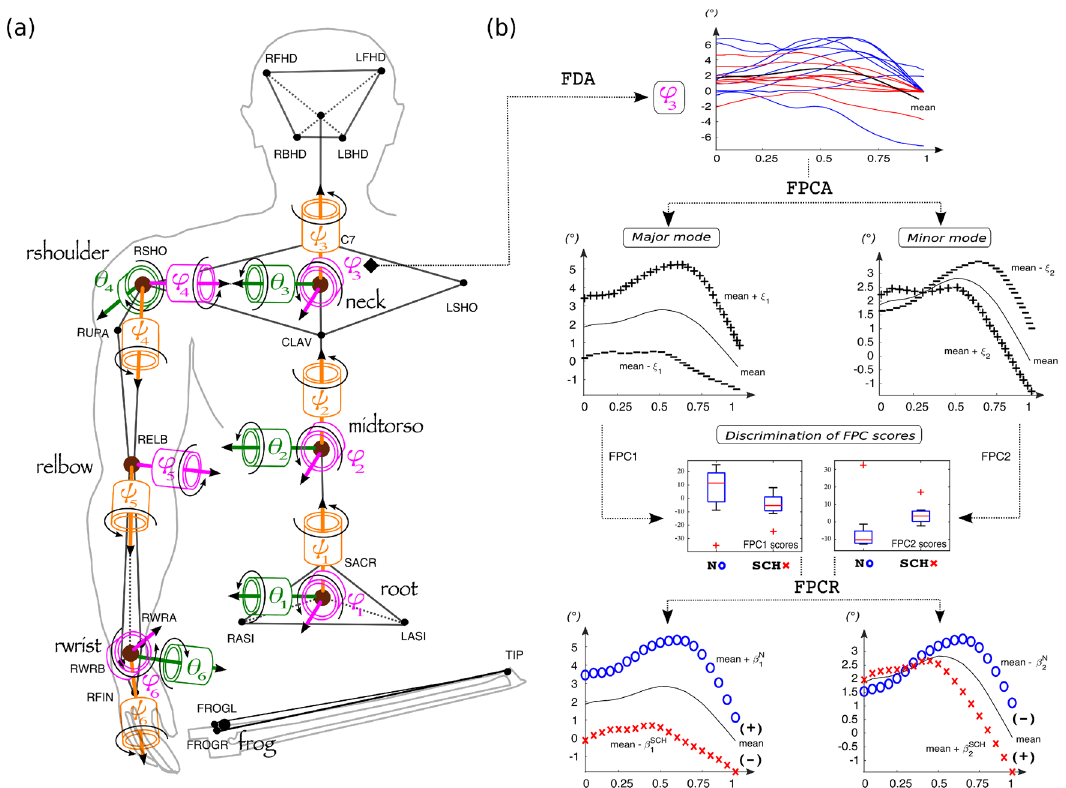
Figure 2. ( a ) Kinematic model of the cellists’ trunk and right arm bowing presented at rest (frontal view). This inertial system is composed of six key joints modeled as three single axes rotational joints in the Cardan/Euler angle representation {roll ( ψ n ), pitch ( θ n ), yaw ( φ n )} where n ∈ [ 1 . . . 6 ] is the key joint number. ( b ) Statistical framework illustrated for a given anatomic variable of the kinematic model. This framework is based on functional principal component analyses (cf “Methods” section) and extracts two principal modes of variation of the cellists’ behavior, which are referred to as major mode and minor mode in the text. The effects of each mode are highlighted as functional deviations of the average time series between the normal (curves of blue circles) and the constrained situation (curves of red